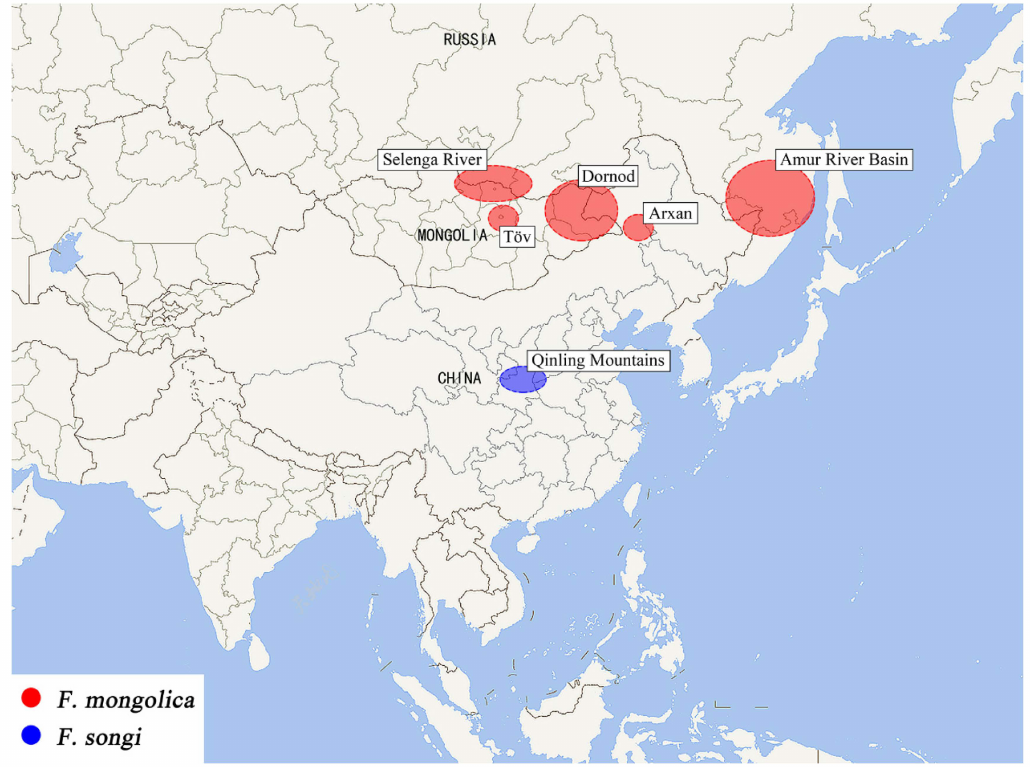
Figure 7. Distribution of Filchneria mongolica and Filchneria songi (map modified by www.tianditu. gov.cn, accessed on 12 October